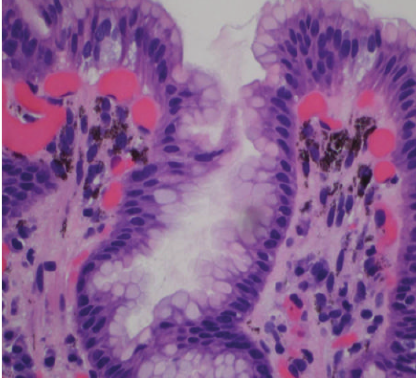
Figure 3: Image 60x of Lamina propria of stomach showing deposition of black